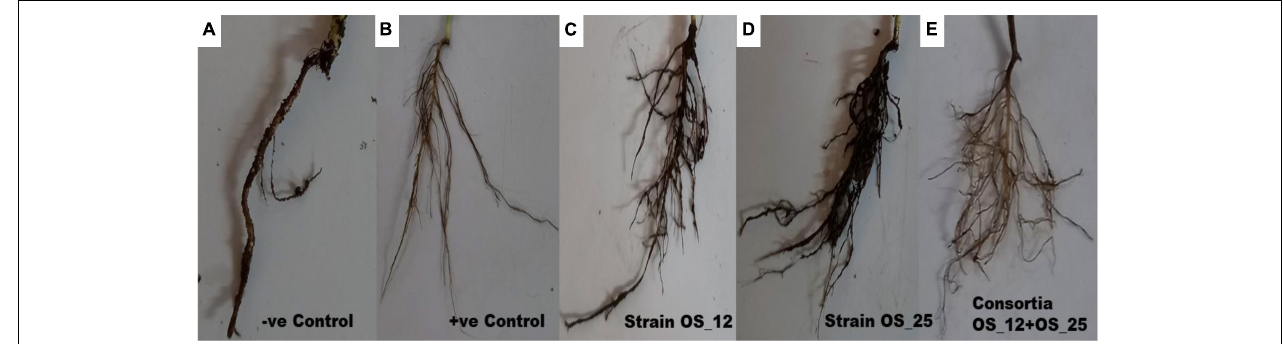
FIGURE 6 | Effect of antagonistic bacterial endophytes strains OS_01 and OS_03 inoculation, single and dual combination on the root rot disease incidence after 7 days in F. oxysporum challenged pea plants. Severity disease symptoms in the roots system of pea plants (A) grown in soil infested with F. oxysporum only, (B) grown in sterile soil without infestation with F. oxysporum , (C) primed with strain OS_12 and grown in infected soil, (D) primed with strain OS_25 and grown in infected soil, (E) primed with bacterial consortia of OS_12 and OS_25 grown in infected soil.